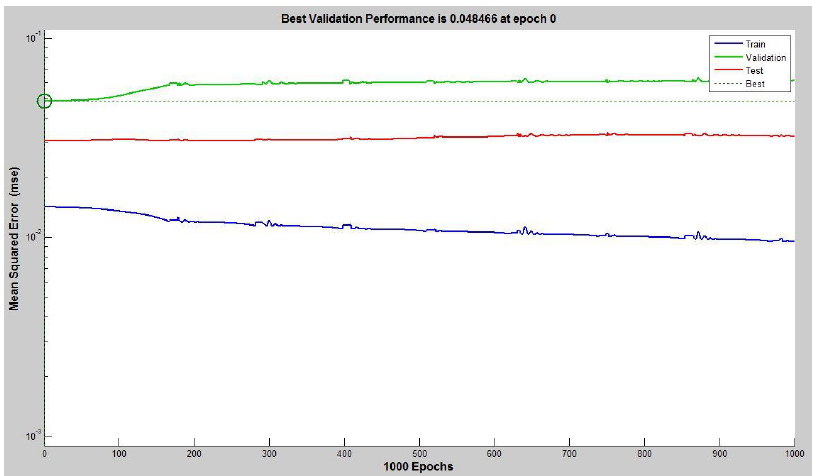
Figure 3. ANN (M 13.10.1 ) validation performance plot of Perigiali Stream.